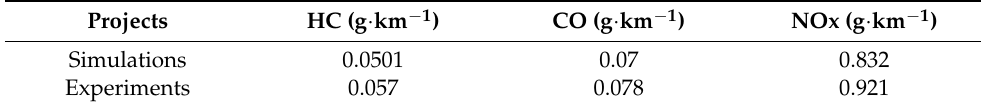
Table 11. Comparison of the simulation and experiment of exhaust